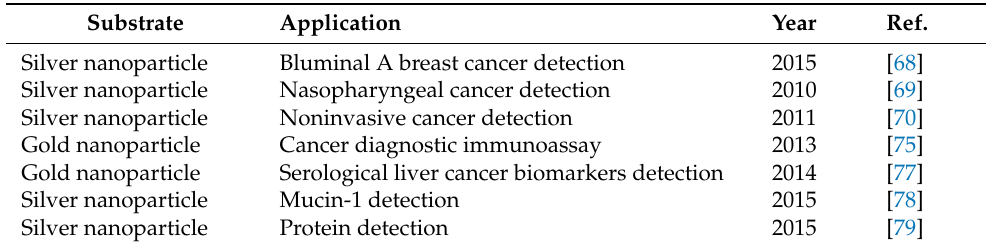
Figure 5. Scheme of the SERS aptasensor for the detection of Mucin-1 based on Au NRs-Ag NP core-satellite assemblies (Feng et al. [78]). Table 2. SERS for protein